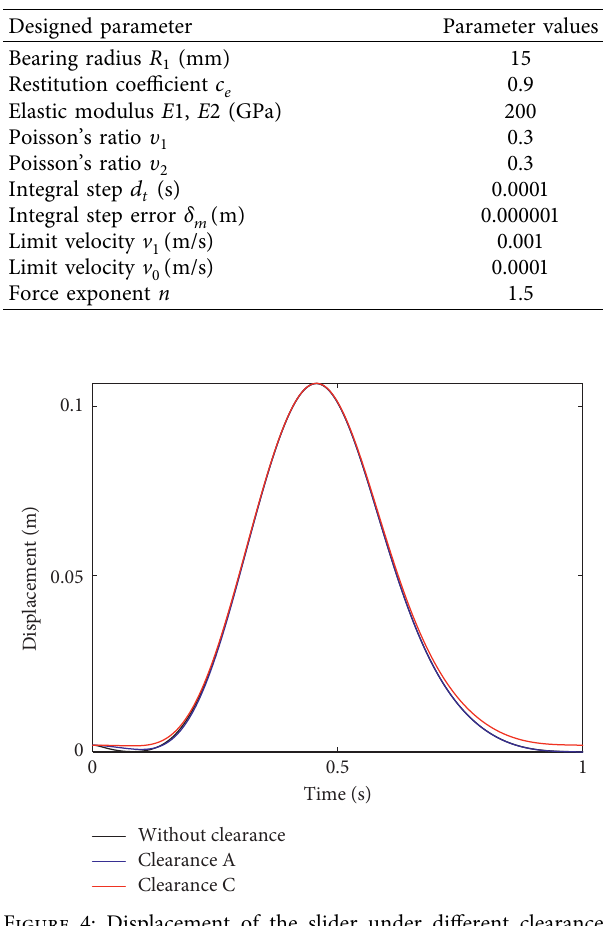
Table 3: Revolute clearance joint parameters.